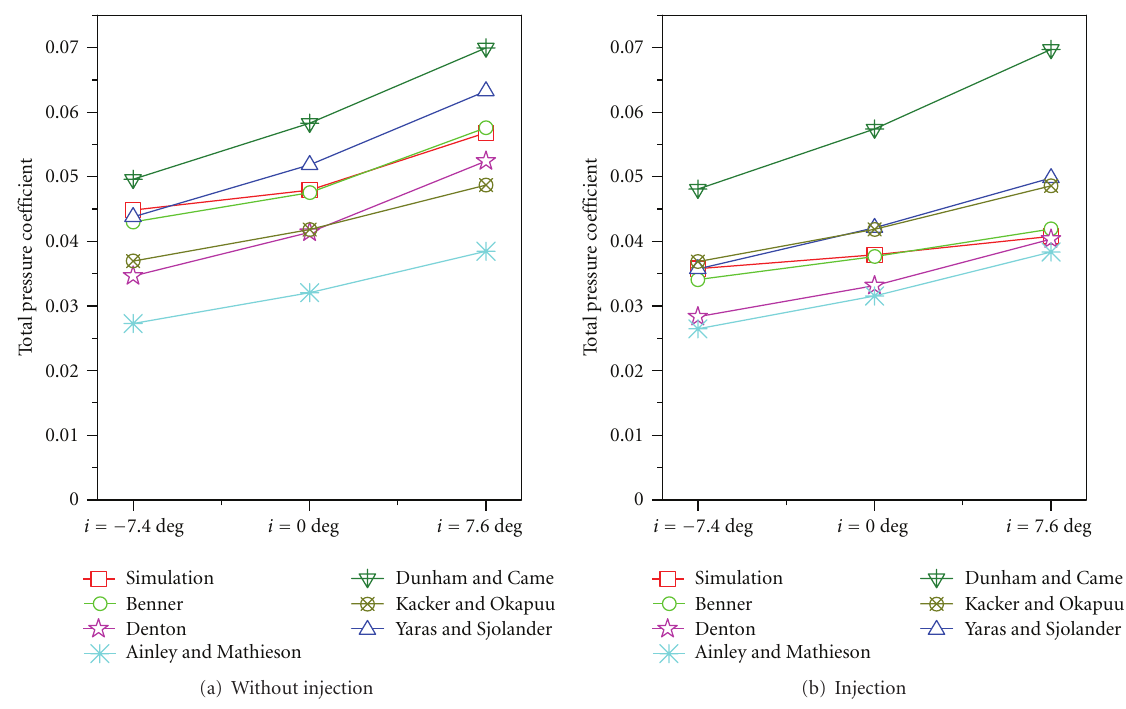
Figure 11: Comparison of the tip clearance losses between the simulation and the empirical